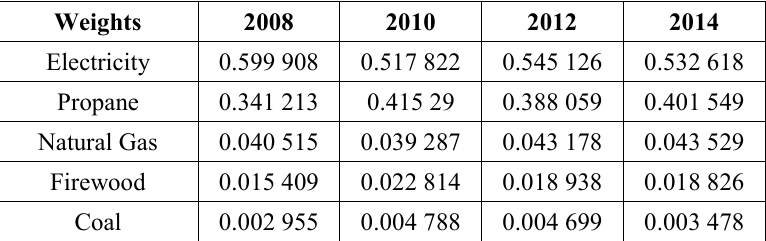
Table 2. Calculated Weights for Energy